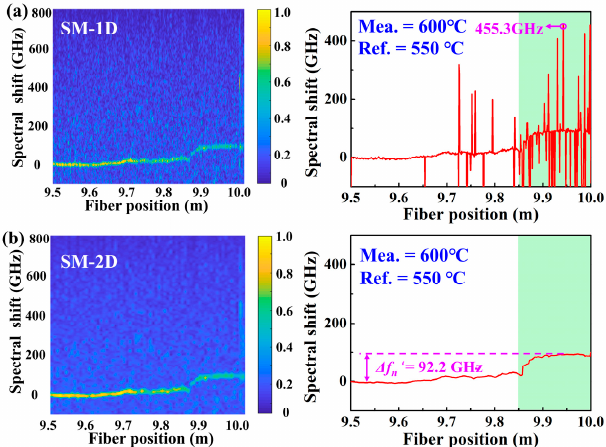
Figure 3. Temperature distribution demodulated by using the DM combined with 1D and 2D methods, i.e., ( a ) DM-1D, ( b ) DM-2D, respectively, at the temperature of 600 ◦ C. The FUT between 9.85 and 10.0 m was placed in the furnace, represented by the cyan box. Note that in the DM, the Ref. signal and Mea. signal were defined as signals acquired at the temperature of 50 ◦ C and 600 ◦ C, respectively.